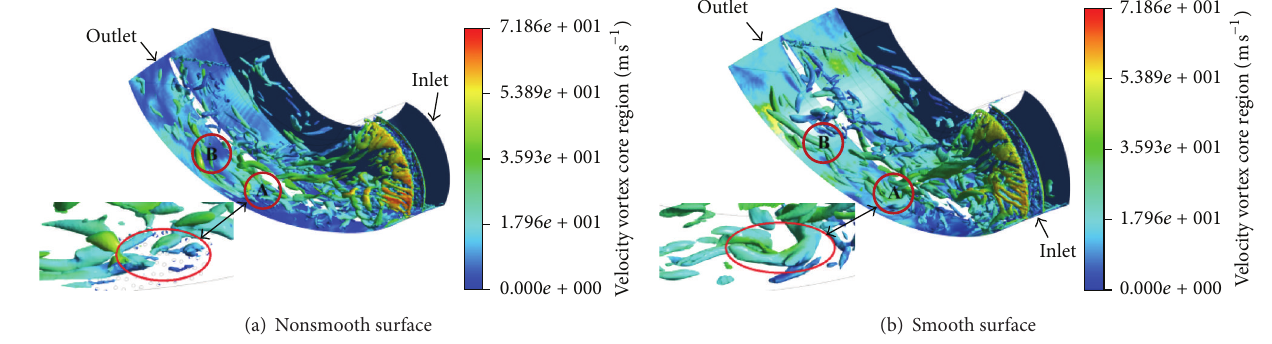
Figure 16: Structure on vortex core